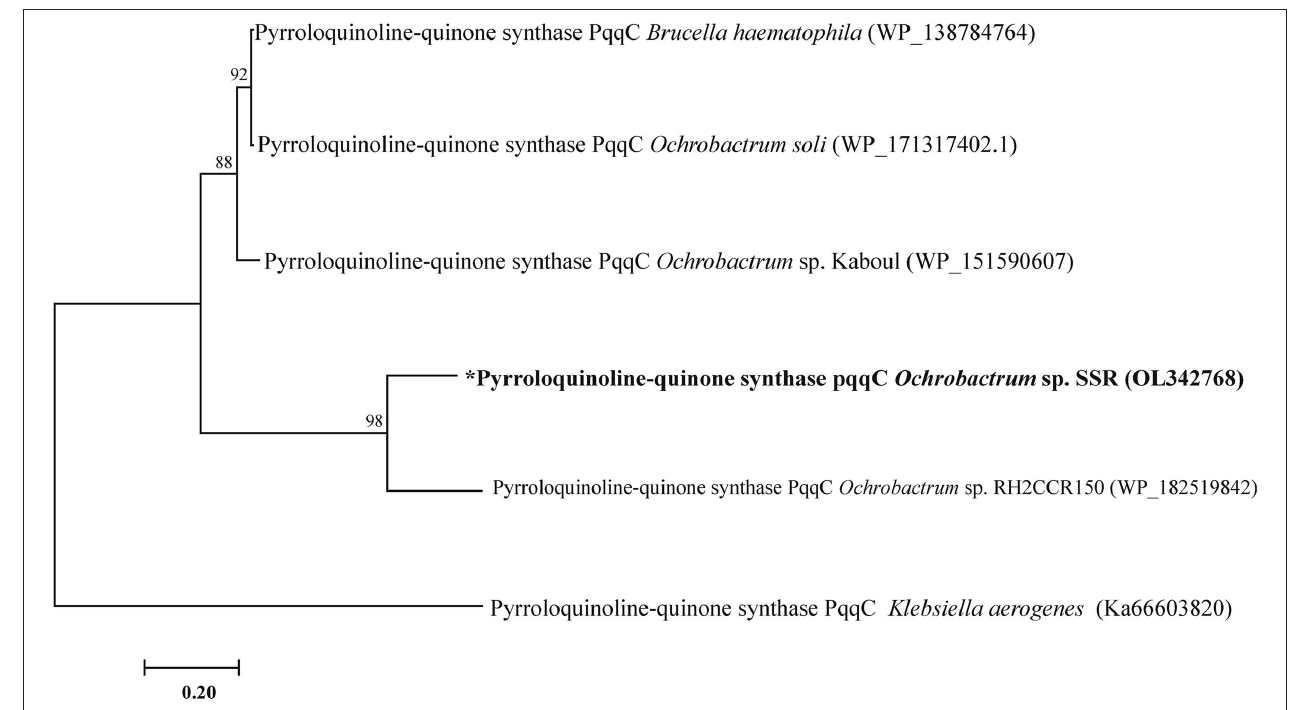
FIGURE 1 | Phylogenetic tree of pqqC gene of Ochrobactrum sp. SSR. Phylogenetic trees was constructed by maximum likelihood method.